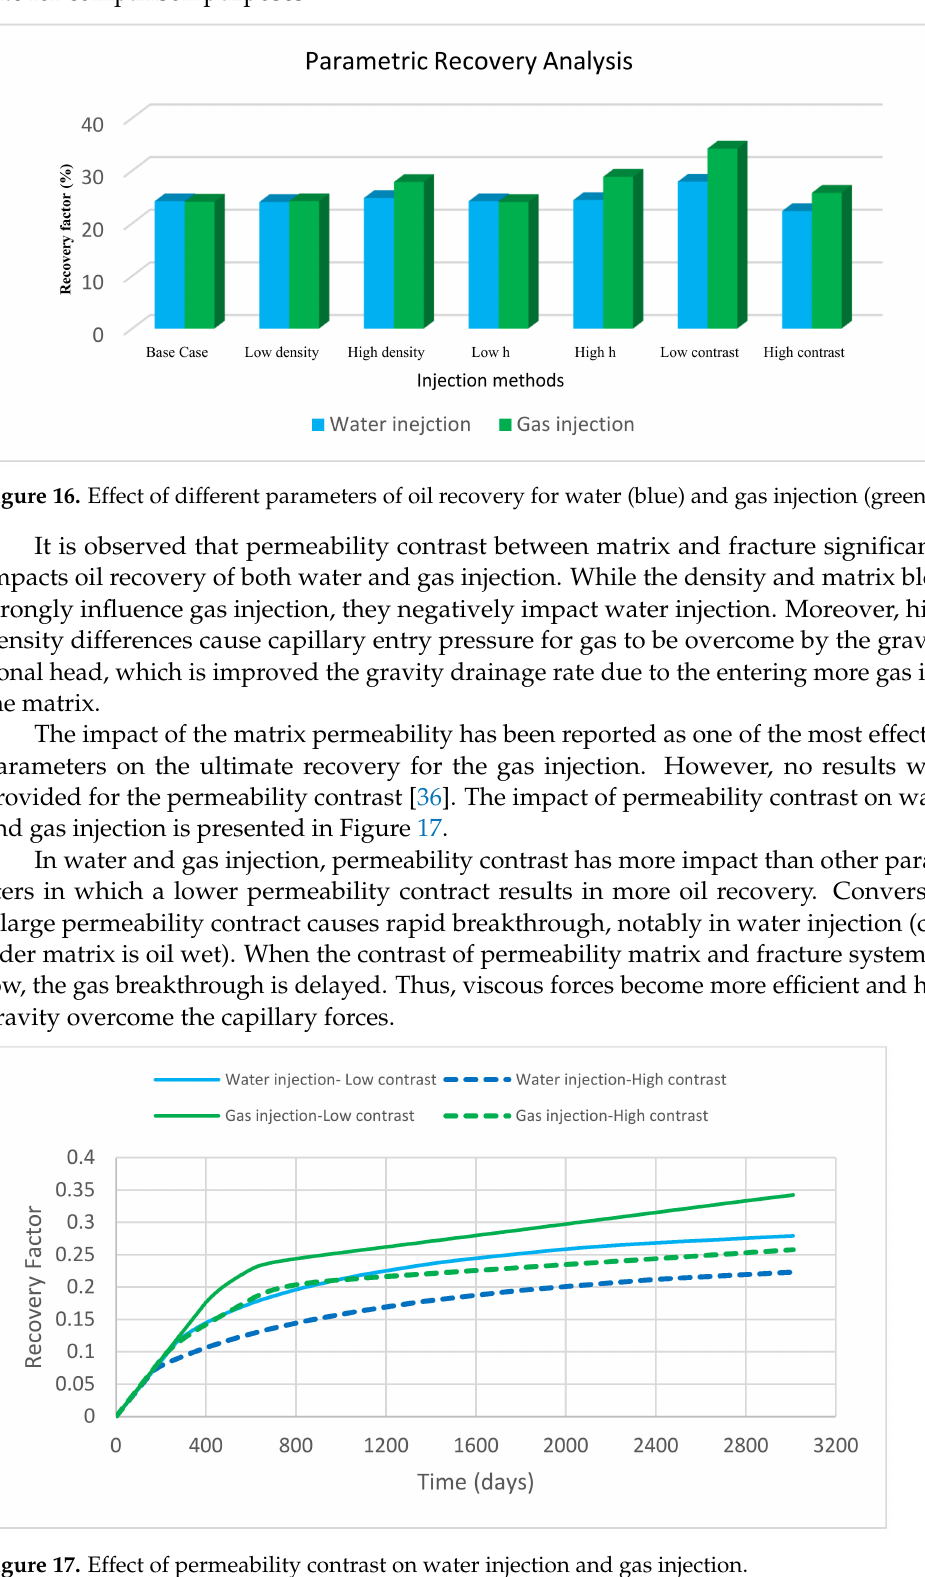
Figure 17. Effect of permeability contrast on water injection and gas